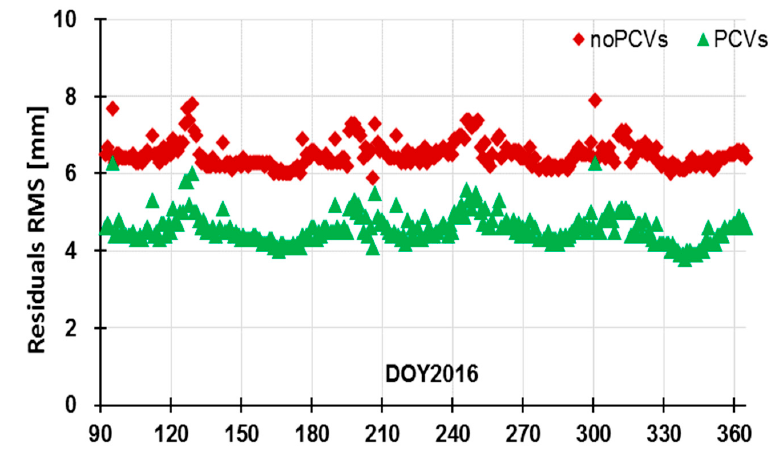
Figure 10. Residuals RMS statistics for Jason-3 POD.